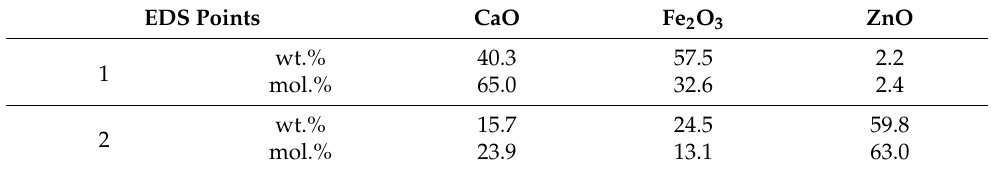
Table 3. EDS analysis of the roasted product with the roasting time of 1 h.